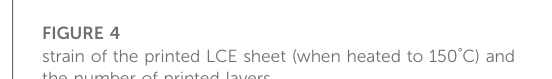
FIGURE 4 strain of the printed LCE sheet (when heated to 150 ° C) and the number of printed